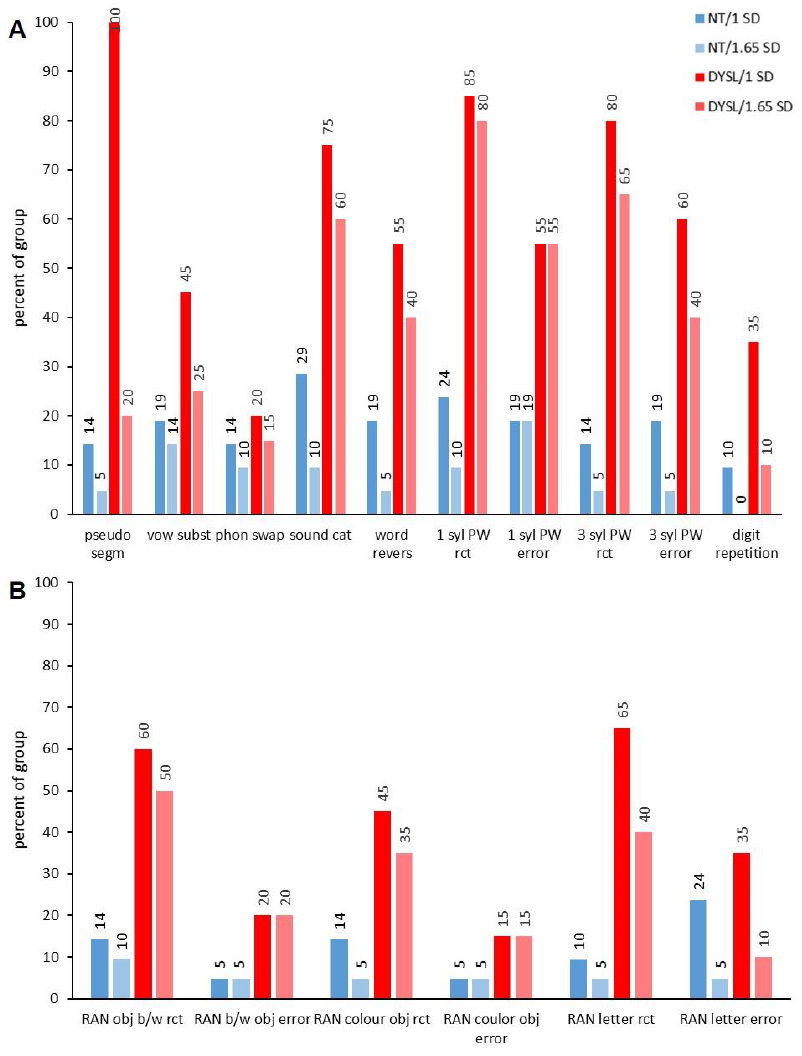
Figure 2. Deviating performance/phonological subtests. ( A ) Subtests of phonological awareness and phonological working memory. ( B ) Subtests of rapid automatized naming. NT: neurotypical normal reading children, DYSL: children with dyslexia, pseudo segm: segmentation of pseudowords, vow subst: vowel substitution, phon swap: swapping of phonemes, sound cat: judging similarity of speech sound categories, word revers: reverse speech sounds of a word, syl: syllables, PW: pseudowords, RAN: rapid naming, b/w: black and white, obj: object, rct: reaction time.